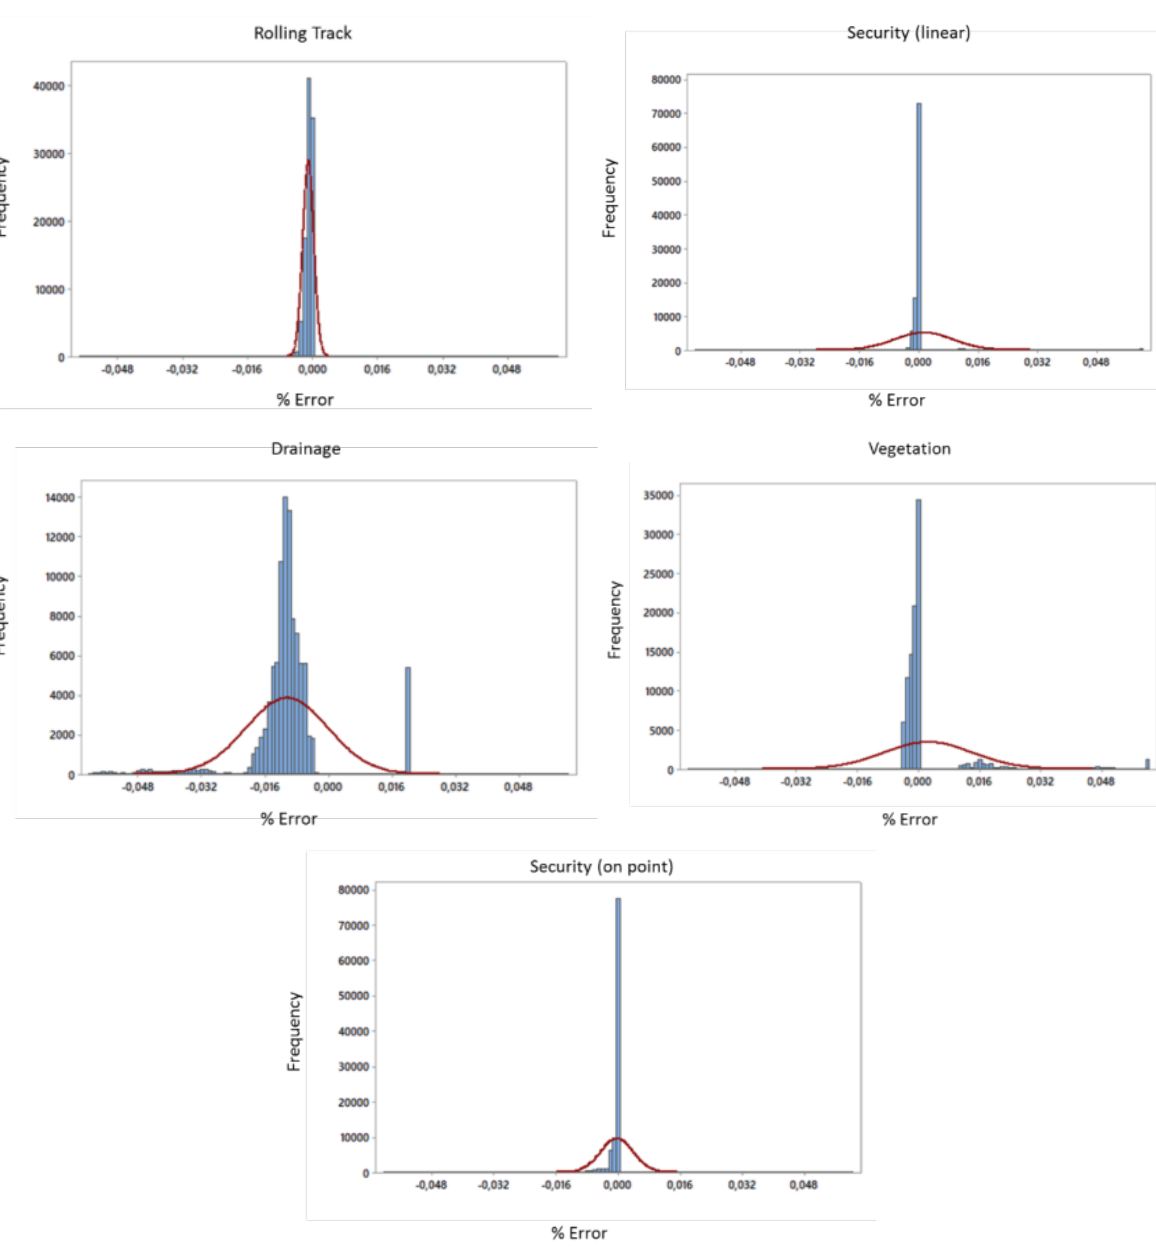
Figure 3. Error rate histogram by Monte Carlo